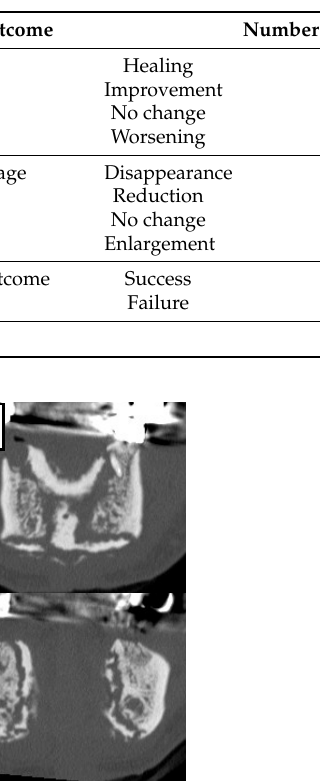
Table 2. Treatment outcome.